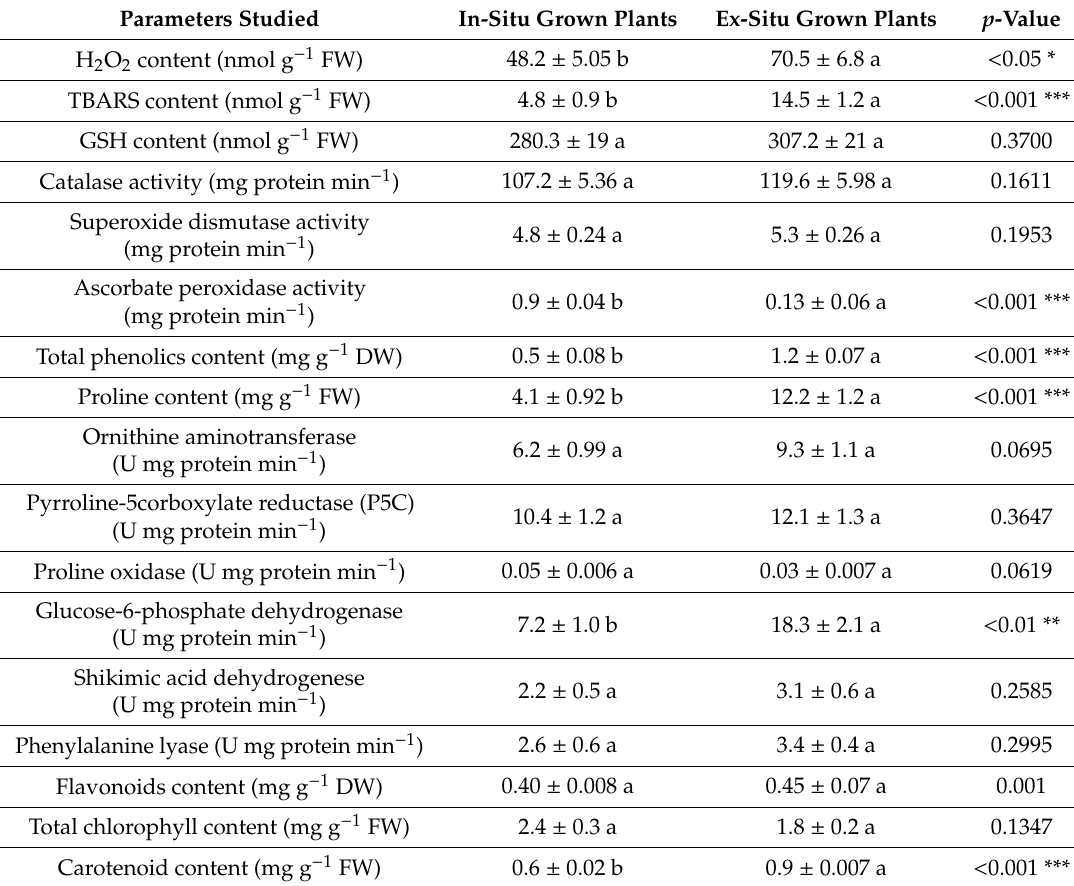
Table 1. Content of H 2 O 2 , TBARS and GSH, activity of catalase (CAT), superoxide dismutase (SOD), ascorbate peroxide (APX), total phenolics content, proline content, ornithine aminotransferase, pyrroline-5-corboxylate reductase, proline oxidase, glucose-6-phosphate dehydrogenase, shikimic acid dehydrogenese, phenylalanine lyase, flavonoids content, carotenoid content and total chlorophyll content in in-situ and ex-situ grown plants of Valeriana wallichii . Parameters Studied In-Situ Grown Plants Ex-Situ Grown